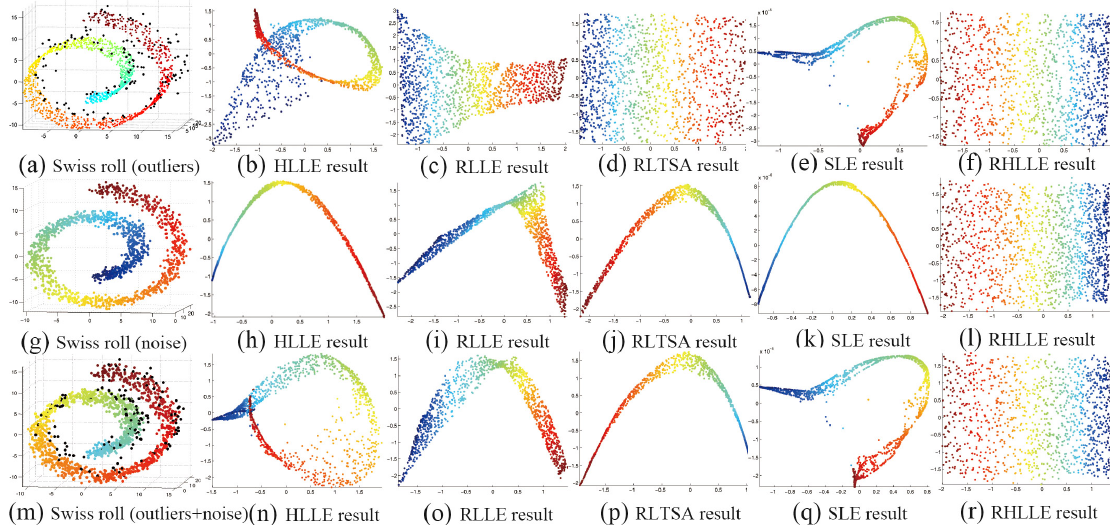
Figure 3. The first row shows the Swiss roll dataset with outliers and the embedding results of different algorithms;The second row shows the Swiss roll dataset with noise and the embedding results of different algorithms; The third row shows the Swiss roll dataset with both outliers and noise and the embedding results of different algorithms.